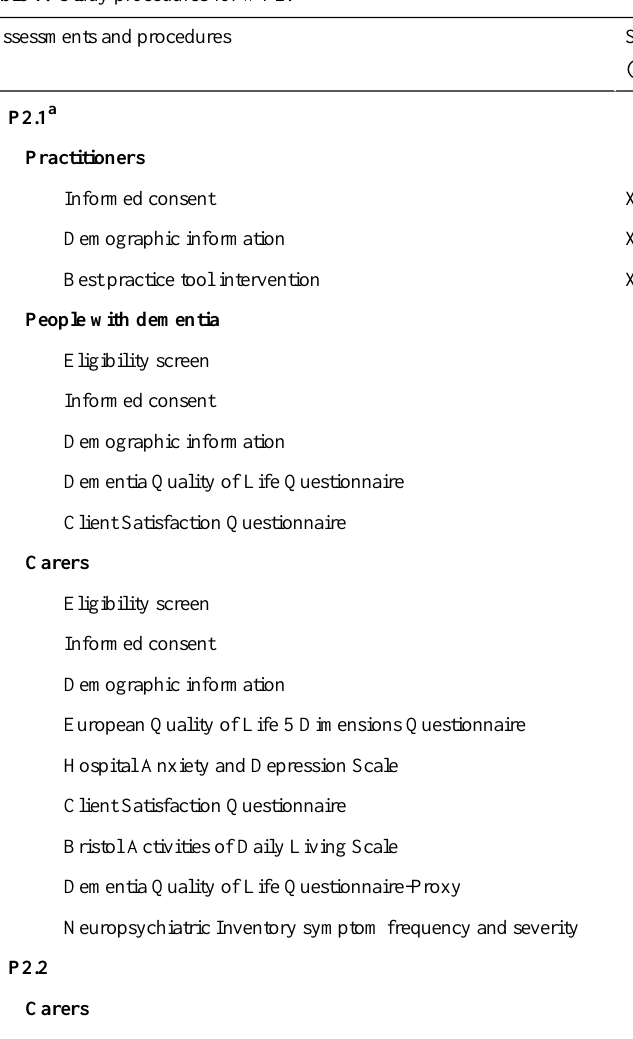
Table 1. Study procedures for